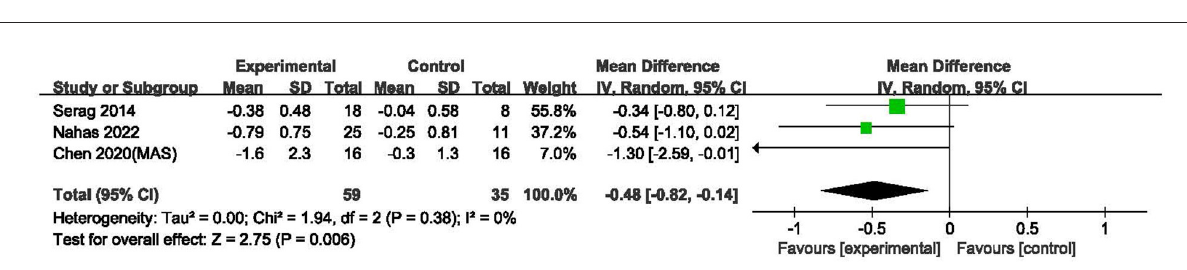
FIGURE5 Meta-analysis of the effect of rPMS on spasticity measured with modified Ashworth scale.